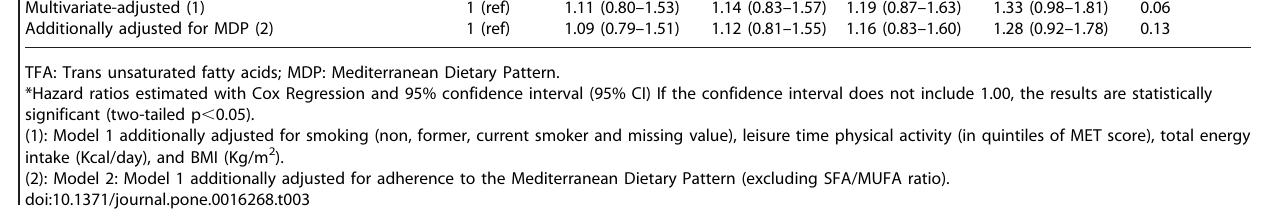
Trans unsaturated fat